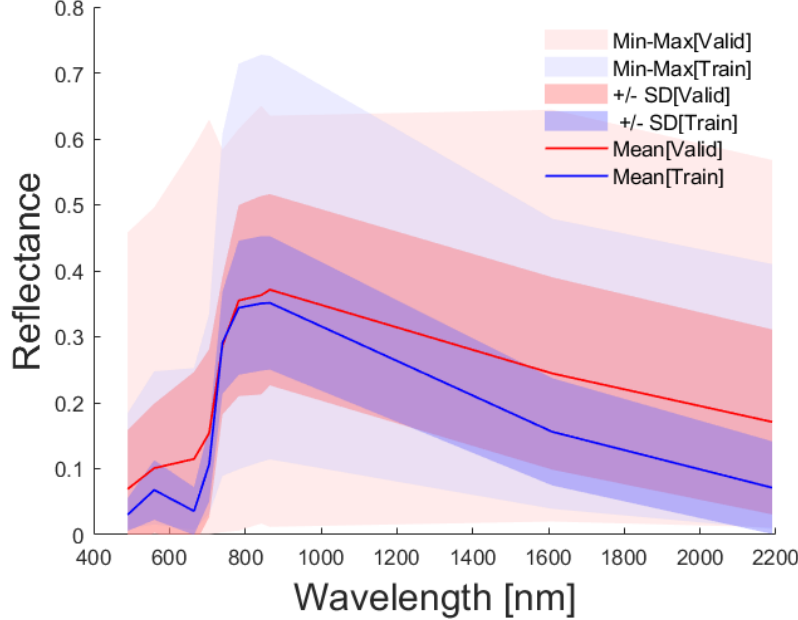
Figure A1. Statistics(mean, standard deviation, min–max) of EBD-reduced final training dataset (blue) vs. validation dataset (red). Training data base was simulated with